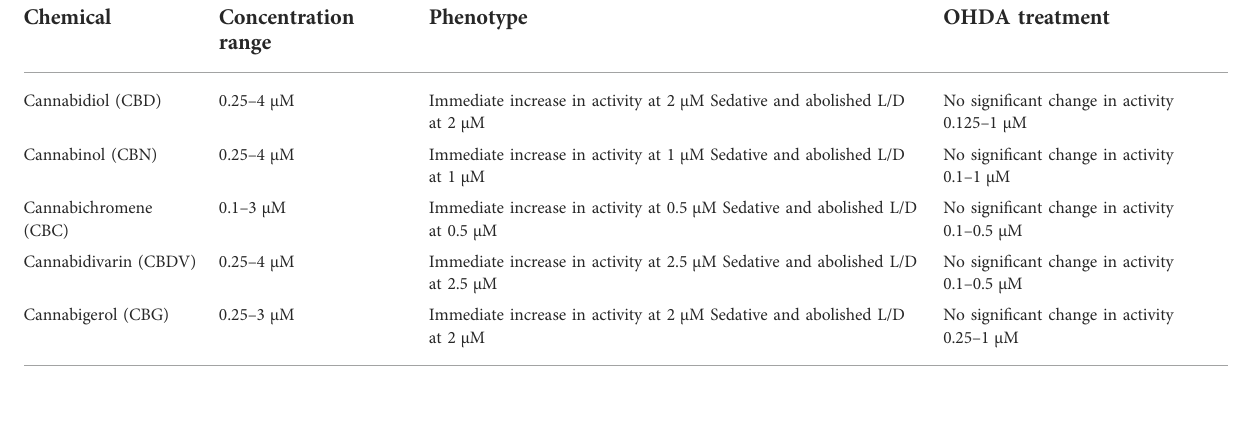
TABLE 1 Cannabinoid dilution series testing results. The effects of puri fi ed individual cannabinoids was tested acutely on 120 hpf zebra fi sh larvae. Also, the pure individual cannabinoids were also evaluated for their ability to reverse OHDA-mediated hypoactivity. L/D = Light/dark startle